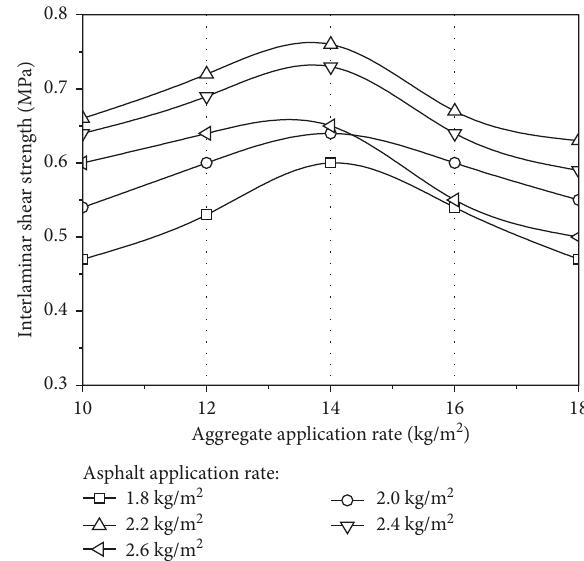
Figure 9: Interlaminar shear test results at 25 ° C.